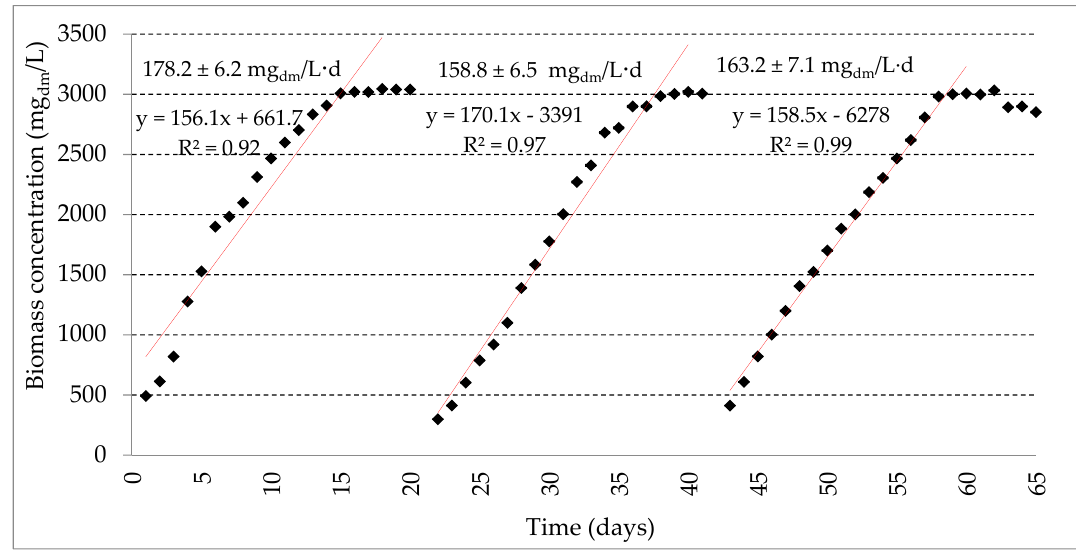
Figure 3. Microalgae biomass production over the cultivation time in Stage 2.